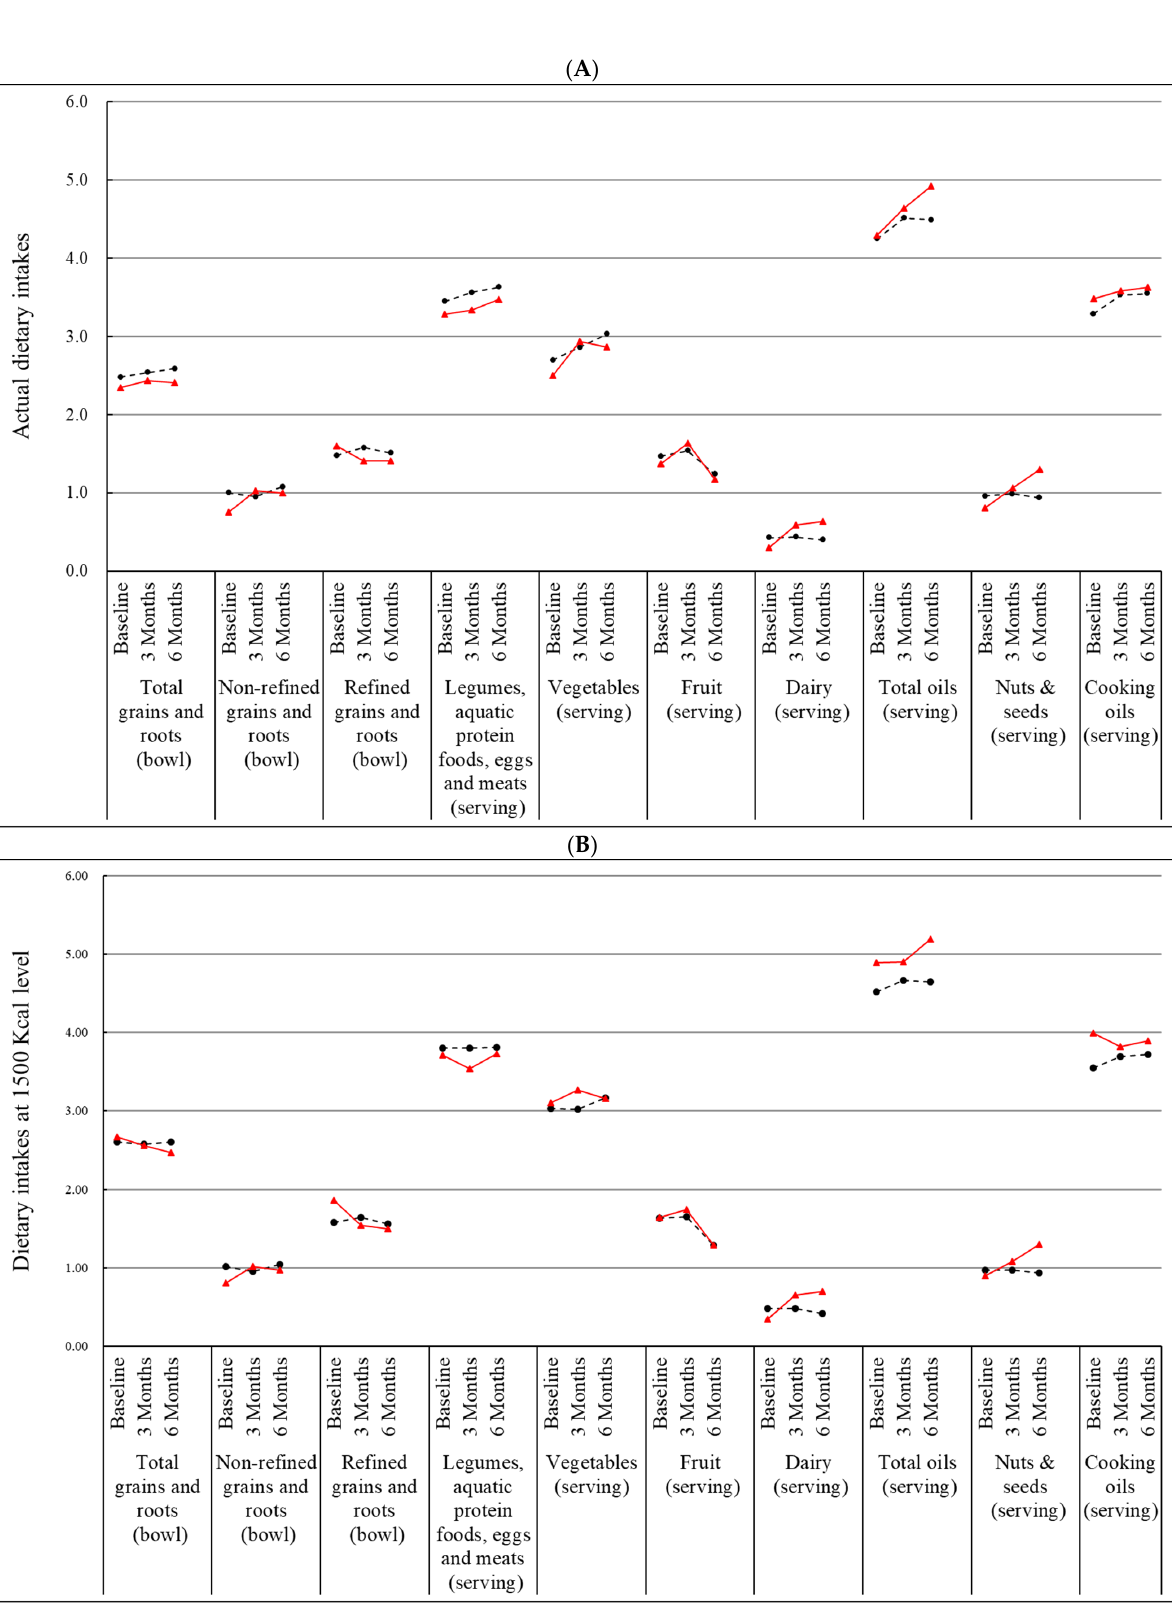
Figure 2. Effect of nutrition education program on dietary intakes. Data are mean change from baseline; n = 124 at 3 months and 108 at 6 months for Control group (black lines), and 87 at 3 months and 79 at 6 months for Nutrition group (red lines). ( A ) Actual dietary intake; ( B ) Dietary intake on the basis of 1500